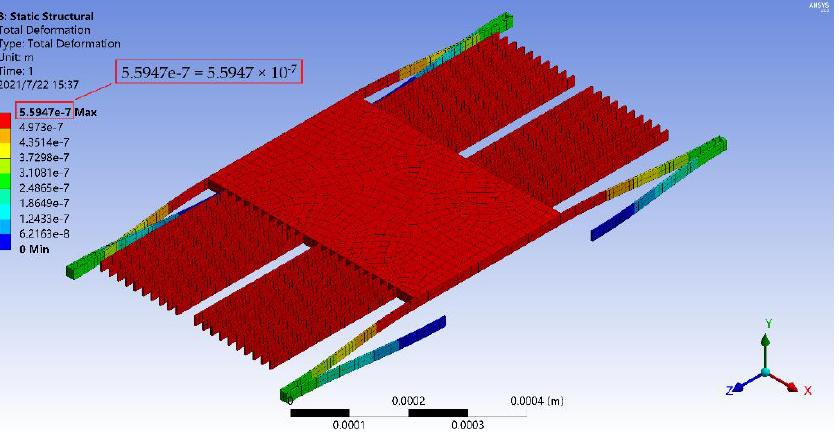
Figure 10. Deformation nephogram of the micro-accelerometer under the acceleration of 100 g along the x -axis. the x -axis.